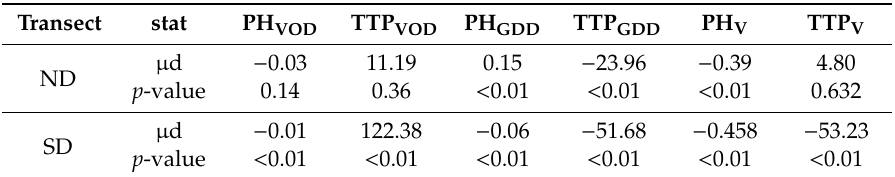
Table 2. Pairwise two sample t-tests for di ff erences in mean di ff erence ( µ d) for metrics between two temporal groups (viz., g2–g1, where g1 is 2003–2005 plus 2007 and g2 is 2013–2016). Bold indicates highly significant ( p < 0.01) di ff erences.